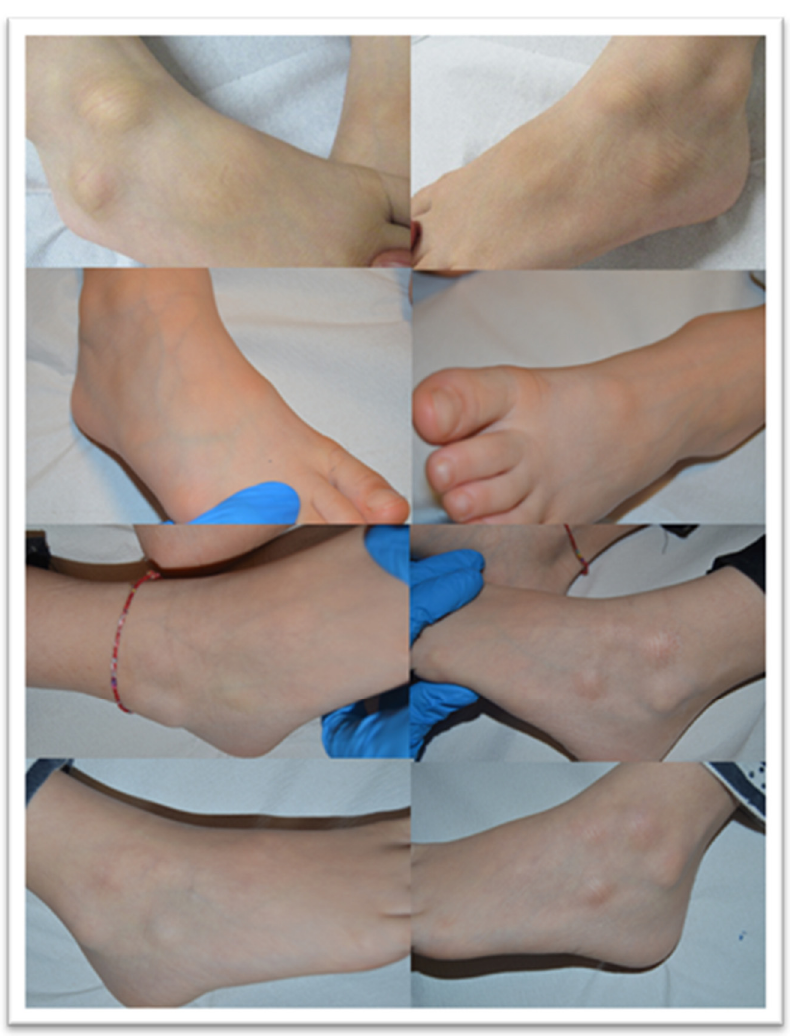
Figure 5. Clinical appearance of the lesions in the second group of patients studied, showing a nodular appearance and overlying erythematous skin.